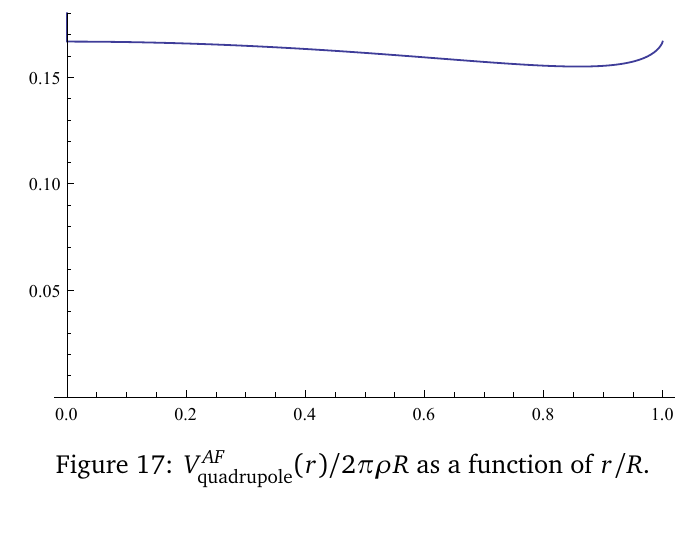
( r ) / 2 πρ R as a function of r / R Figure 17: V AF quadrupole